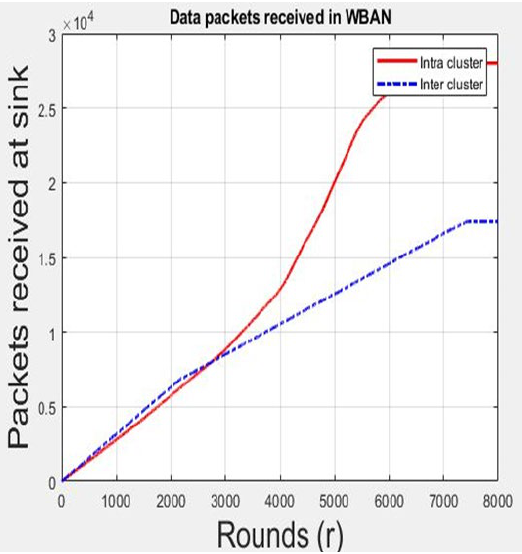
Figure 10. Data packet received in WBAN